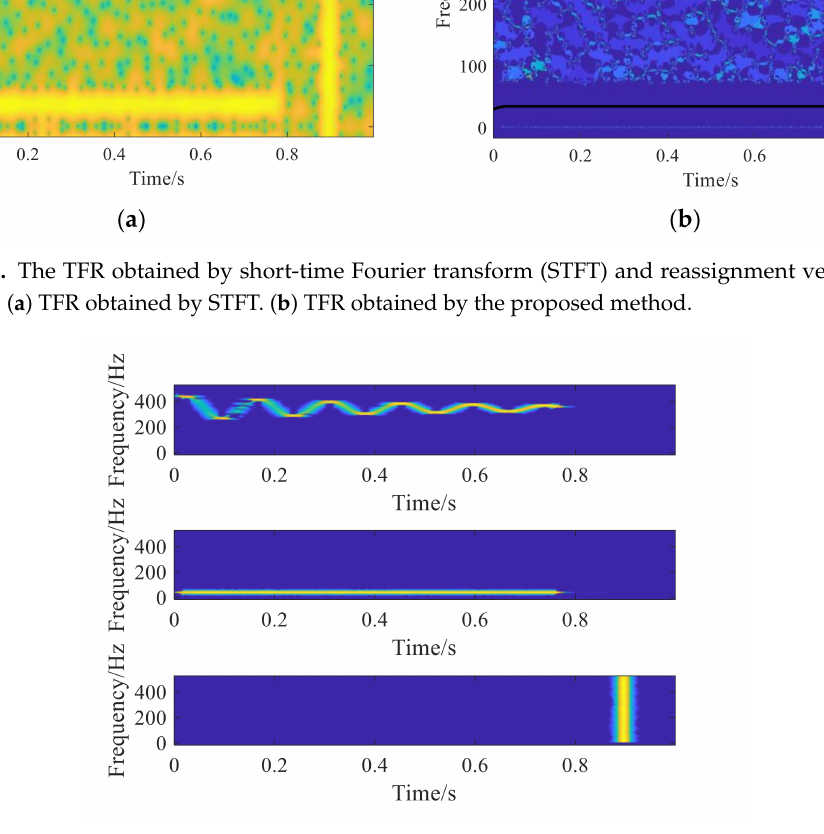
Figure 4. The time-frequency (TF) mode decomposition by the proposed